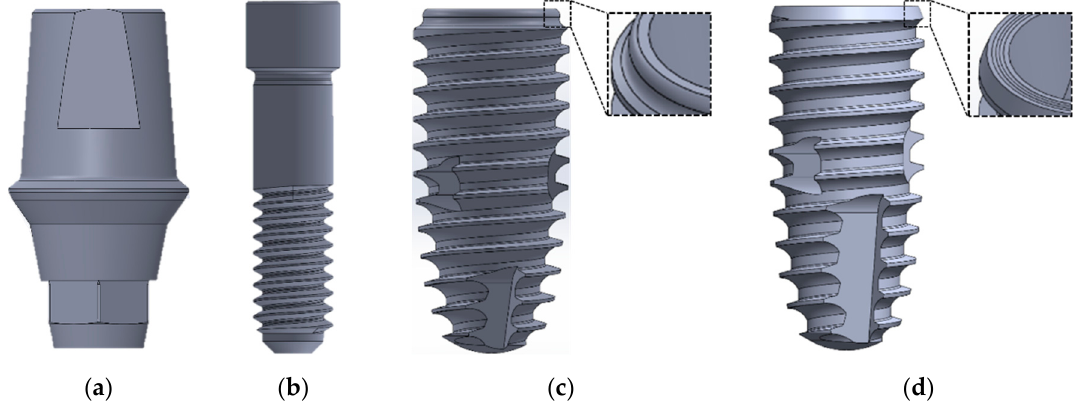
Figure 2. The two different implant fixture models used in the present study. ( a ) Abutment; ( b ) abutment screw; ( c ) CMI IS-II active; ( d ) CMI IS-III active.